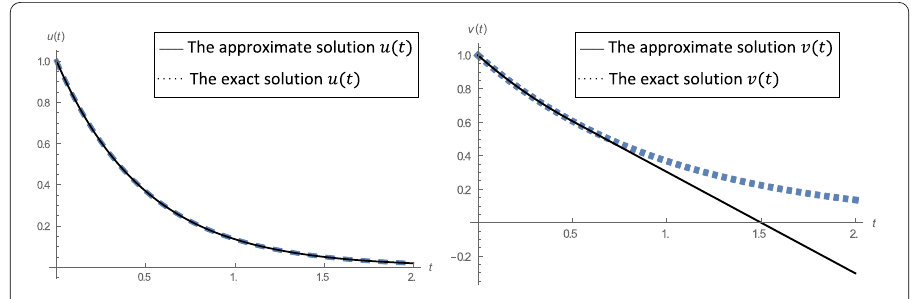
Figure 4 The RK solution behavior of Example 4.2 for α = 1 and k =